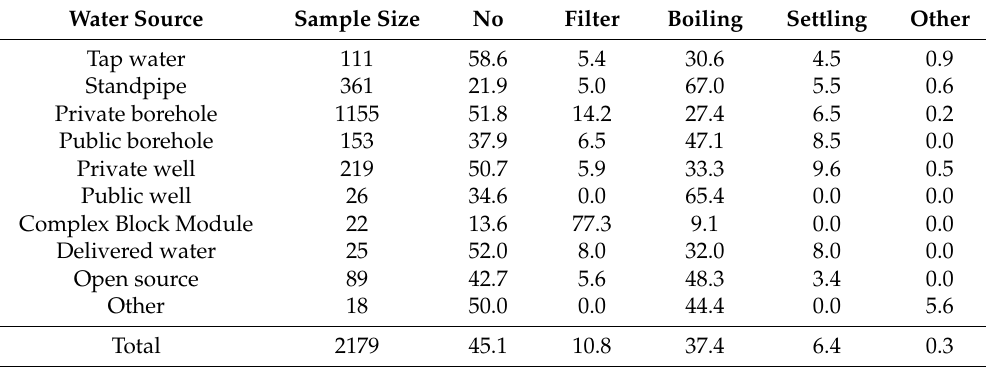
Table 3. Household water treatment (percentage of households giving each